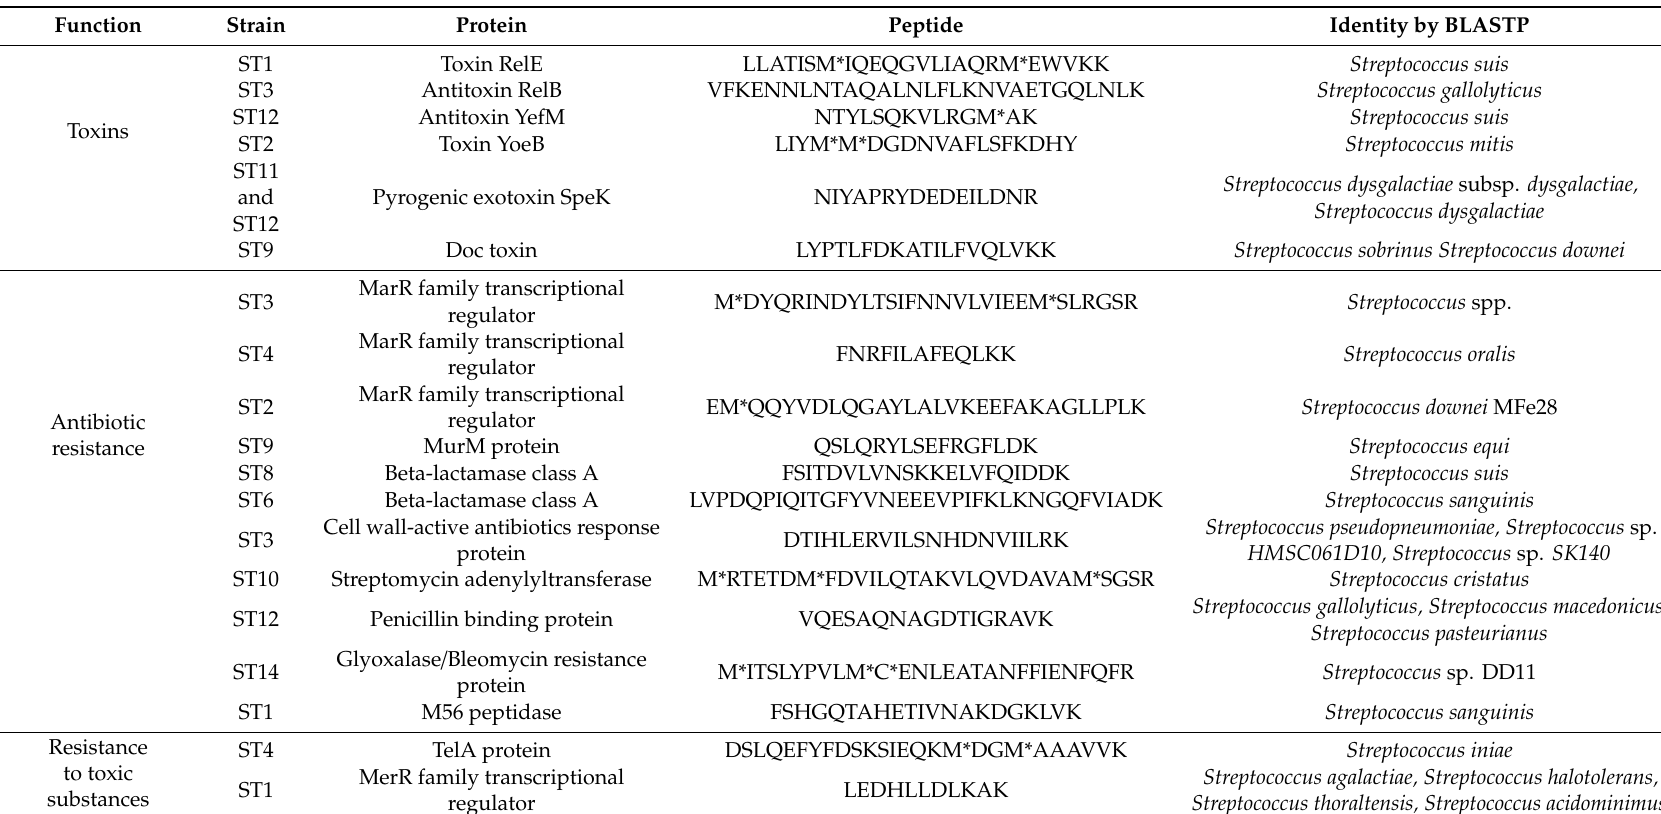
Table 1. Streptococcus -specific peptides, corresponding to virulence factors, identified in the Streptococcus spp. strains